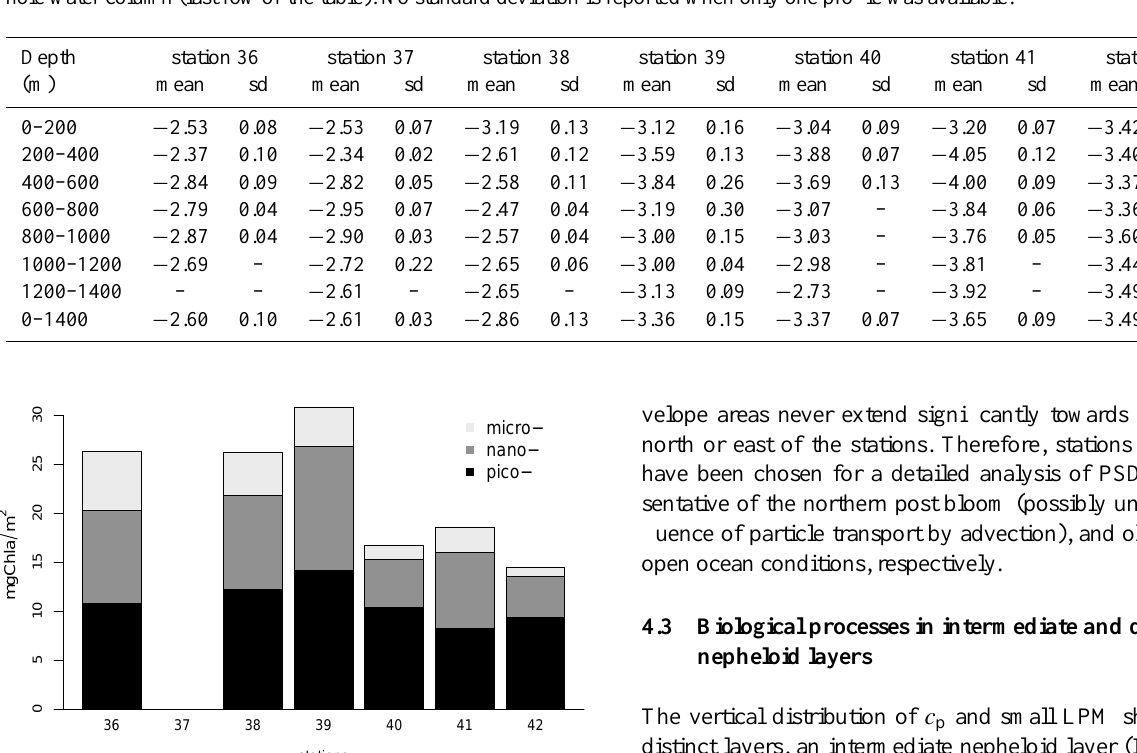
Table 3. Mean and standard deviation of size-spectra (100µm–2mm) slope for all stations, computed for each layer 200m thick and on the whole water column (last row of the table). No standard deviation is reported when only one profile was available.